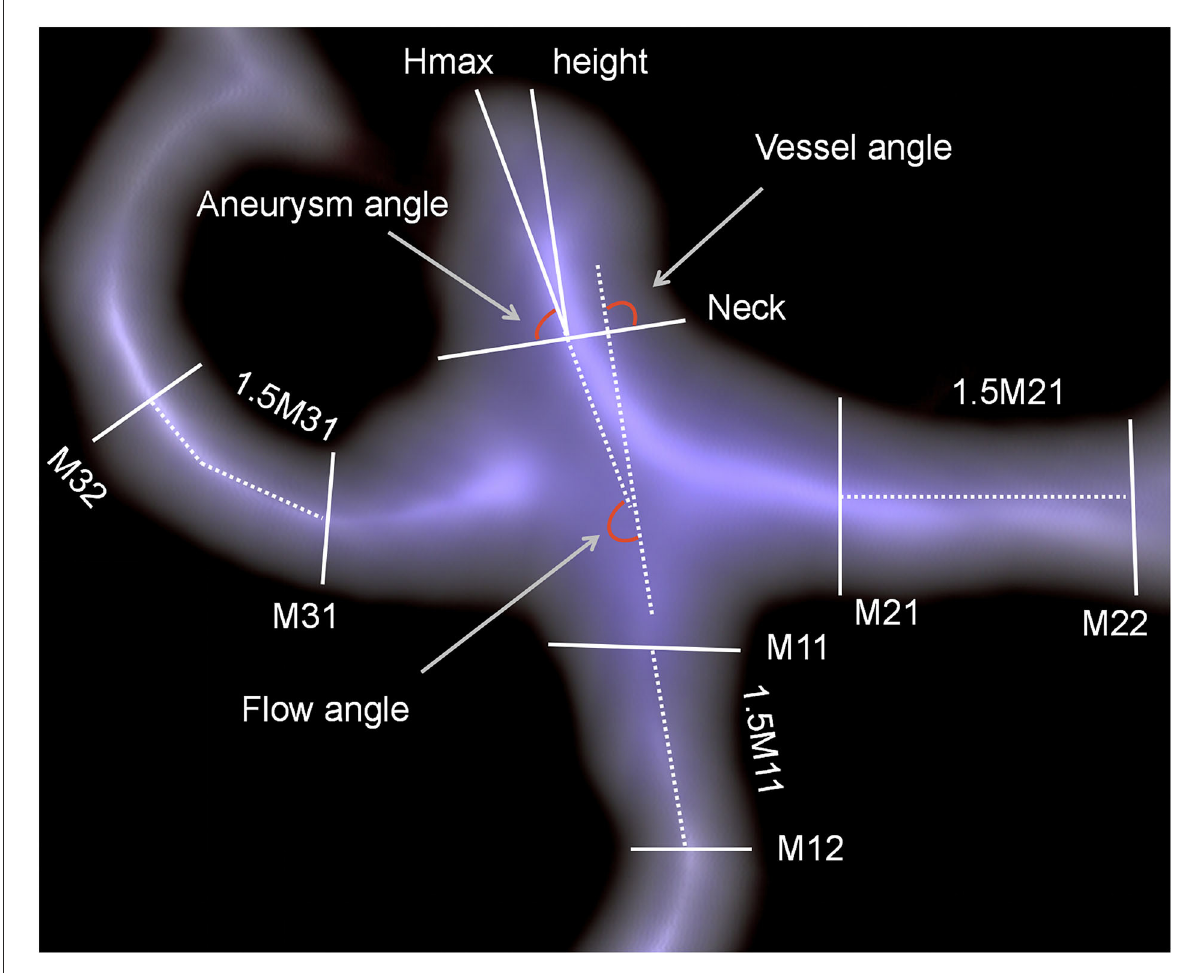
FIGURE2 Measurements of aneurysm morphological